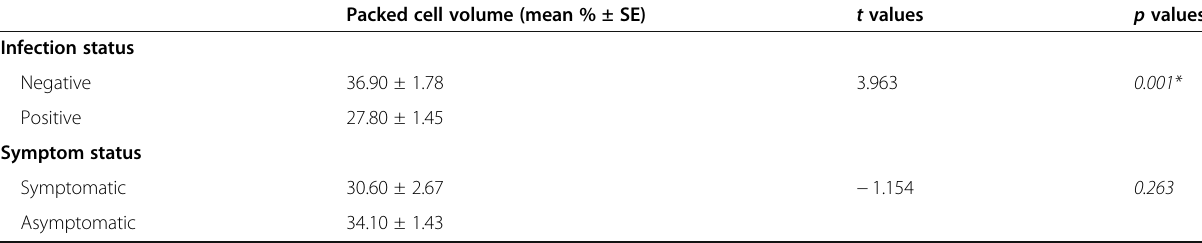
Table 1 Relationship between malaria parasite infection and mean